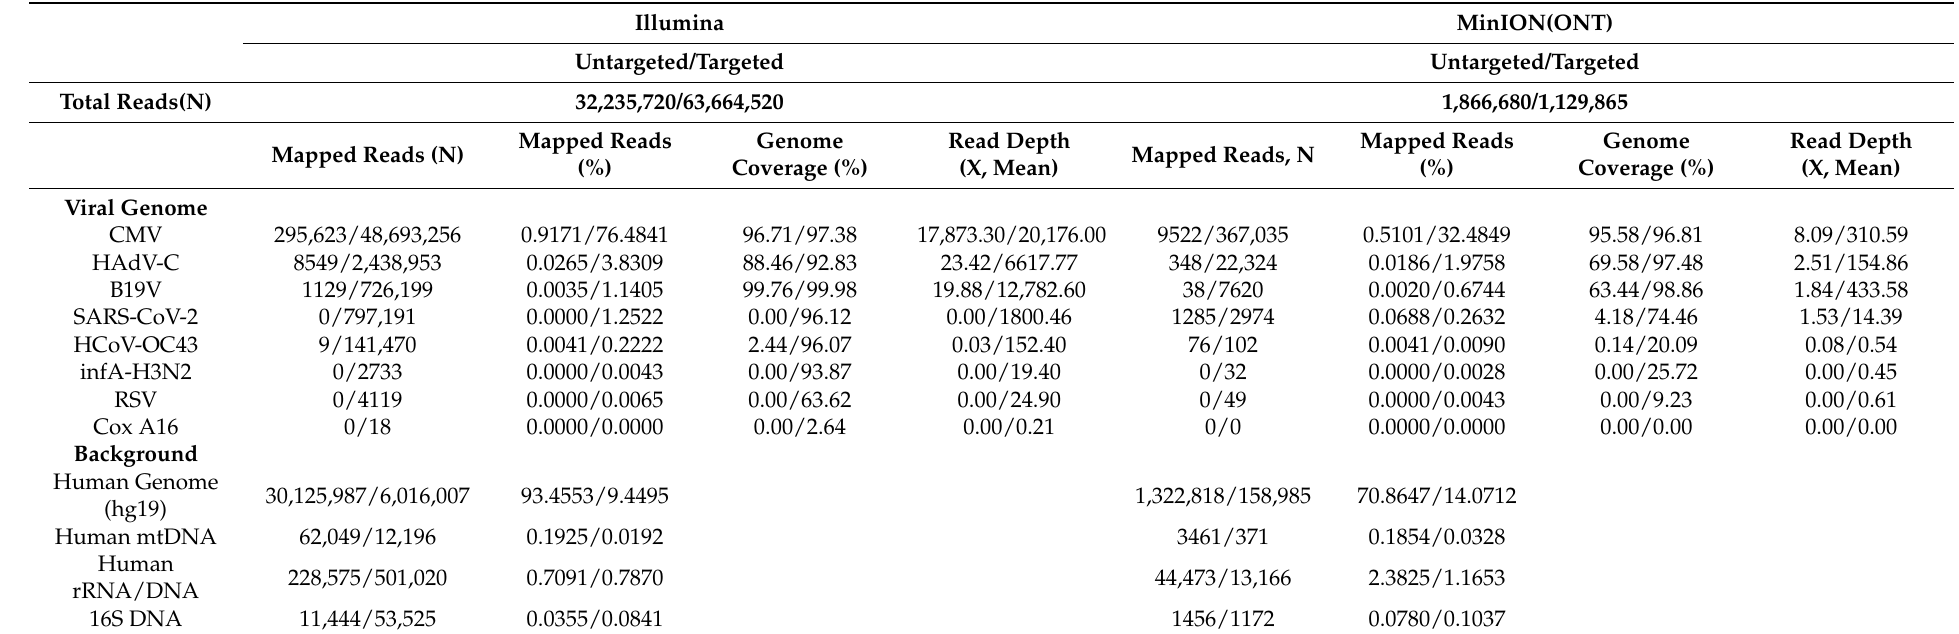
Table 1. Comparison of mapping statistics for untargeted and targeted